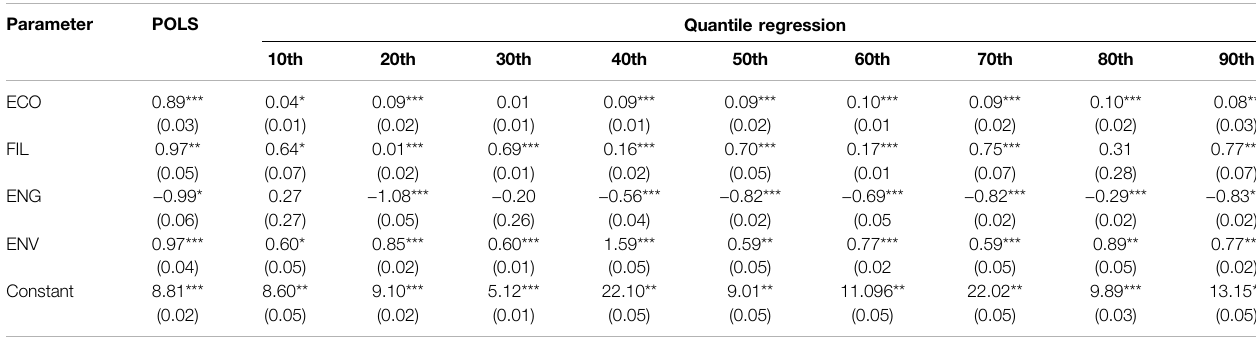
TABLE 6 | OLS and quantile estimation